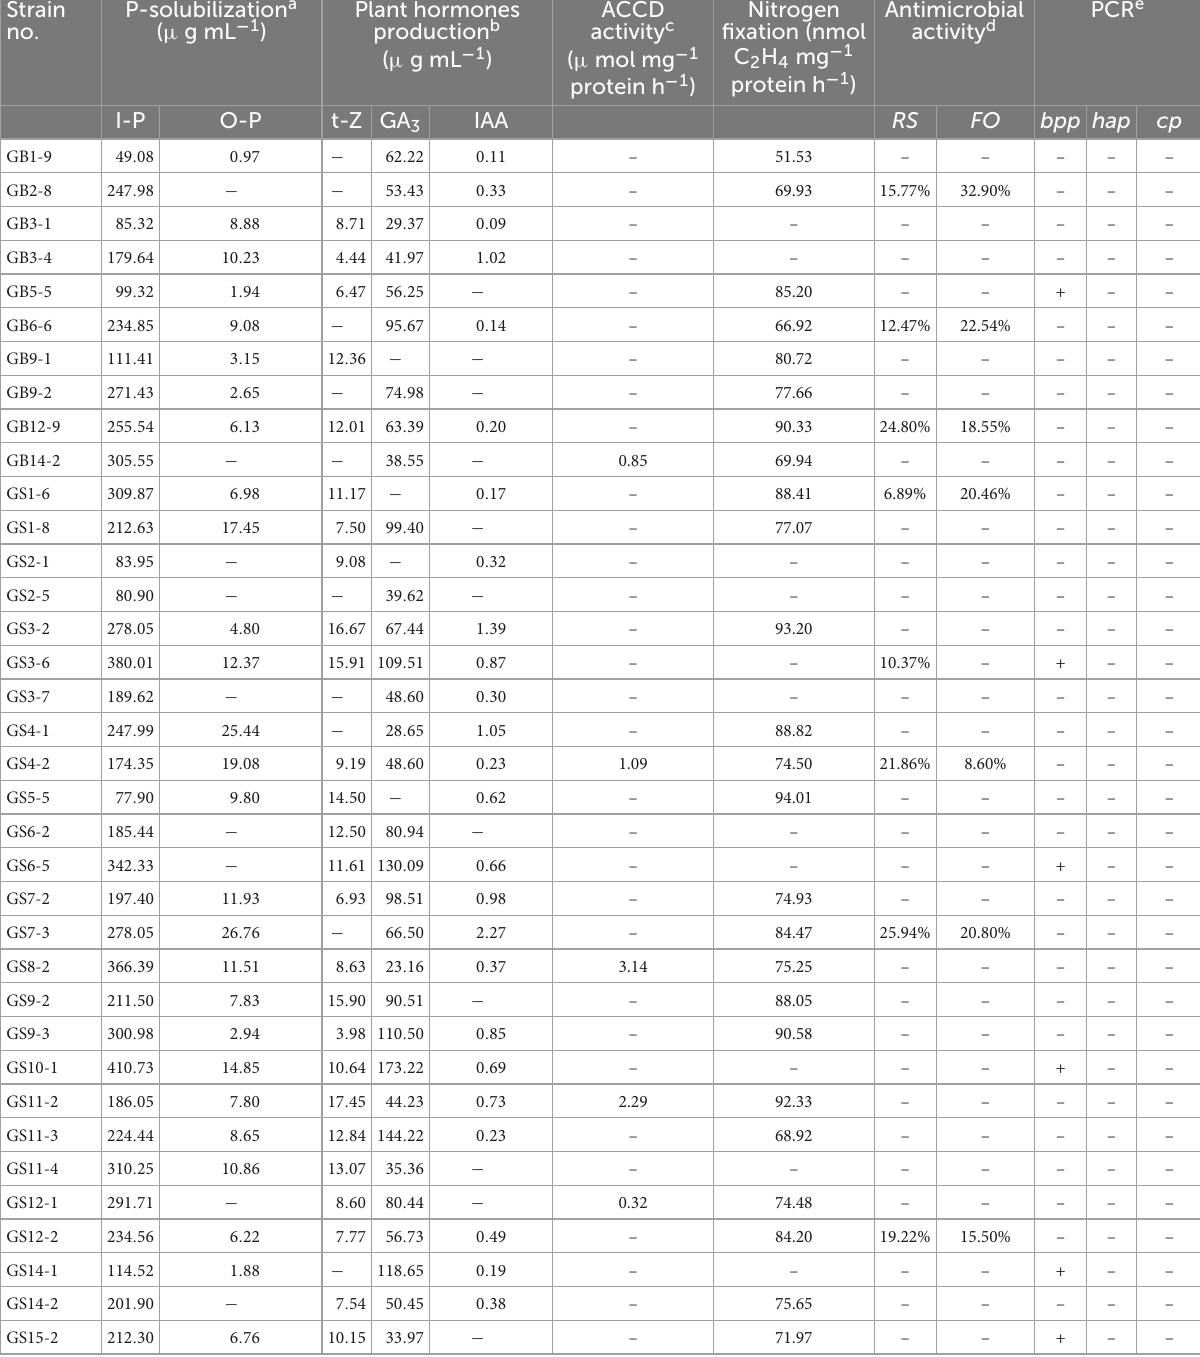
TABLE 1 Screening the in vitro plant growth-promoting (PGP) traits in genus of Pseudomonas. Strain no.